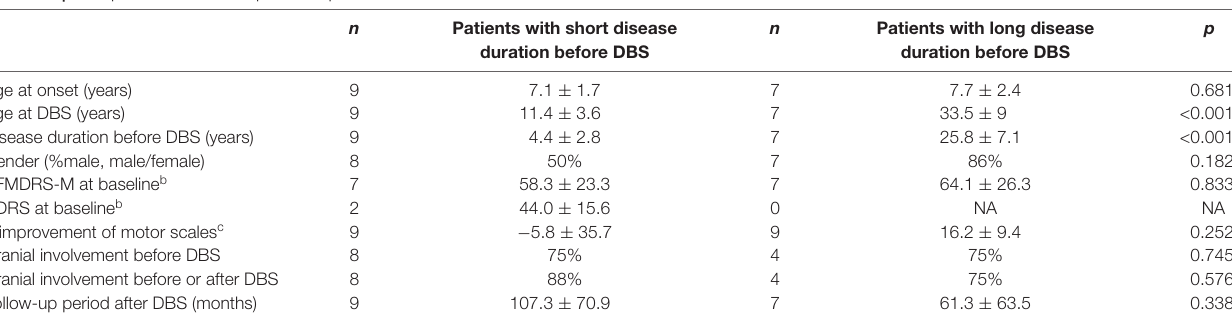
TABLE 4 | Comparison of the suboptimal responders based on disease duration before DBS.